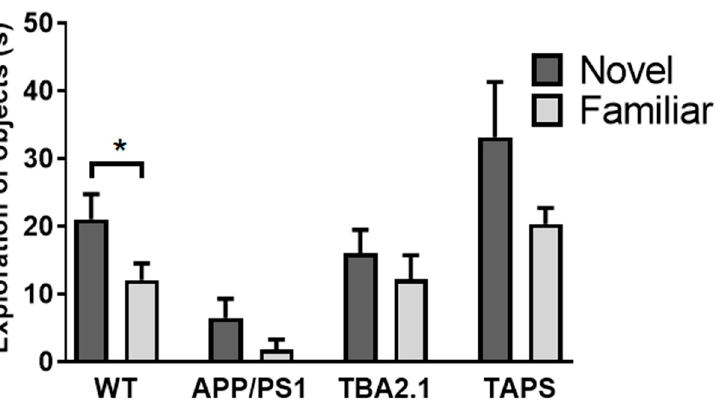
Figure 7. Deficits in the novel object recognition test in TAPS mice. The time animals explored the novel in comparison to a familiar object is given for each mouse line. Only wild-type mice (WT; n = 8) were able to discriminate between the novel and the familiar object (* p = 0.0380) while APP/PS1 ( n = 5), TBA2.1 ( n = 8), and TAPS ( n = 4) mice showed a cognitive deficit in this task. For statistical analysis, a paired t-test was used to evaluate the difference between the exploration time of the novel and familiar object. Data is given as mean +